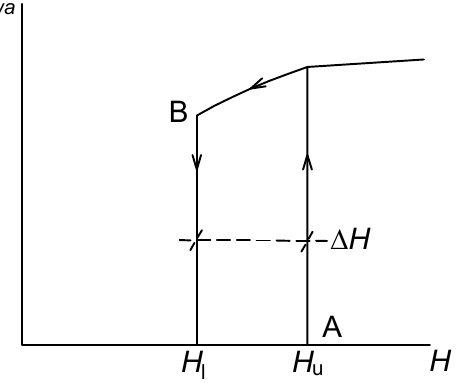
Figure 8. Snapshots showing simulated 0.95 nm pores at 25 ◦ C: ( a ) PW 1 pores at a series of H from top to bottom: 0.000036%, 0.00050%, 0.16%, 0.35%; ( b ) PW 2 pores at a series of H from top to bottom: 0.000036%, 0.60%, 5.57%, 6.34%. Each green ball with attached two magenta balls represent one water molecule, and blues spheres show the position of sorption sites.